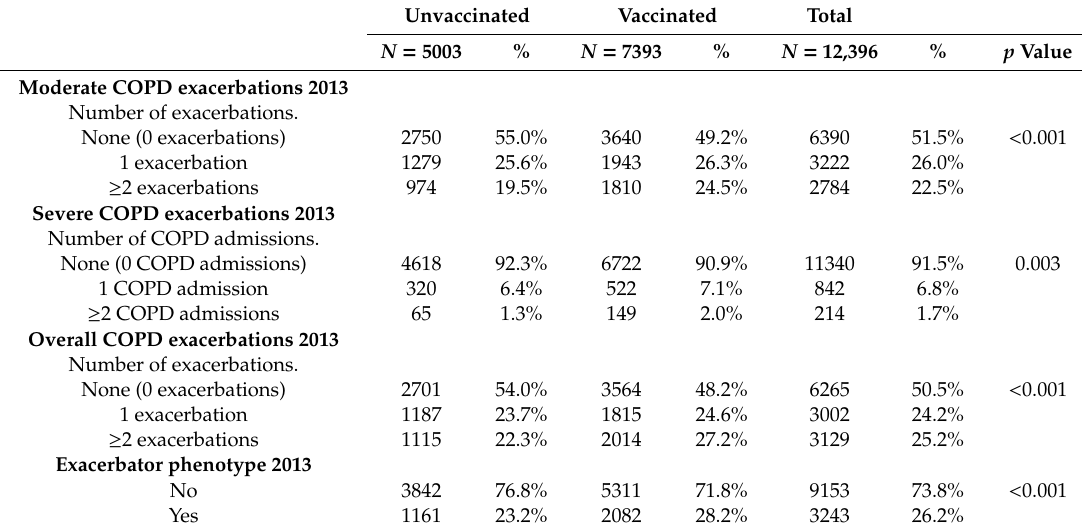
Table 2. Influenza vaccination during the 2012 / 2013 campaign and exacerbations during the following year.